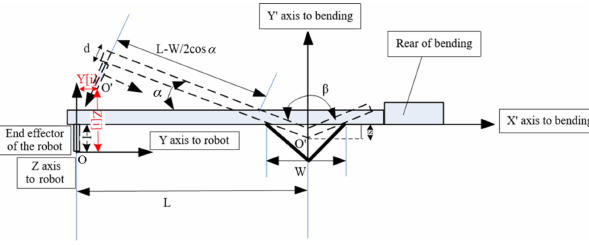
Figure 3. The motion coordinate system of the bending robot fol- lowing the bending